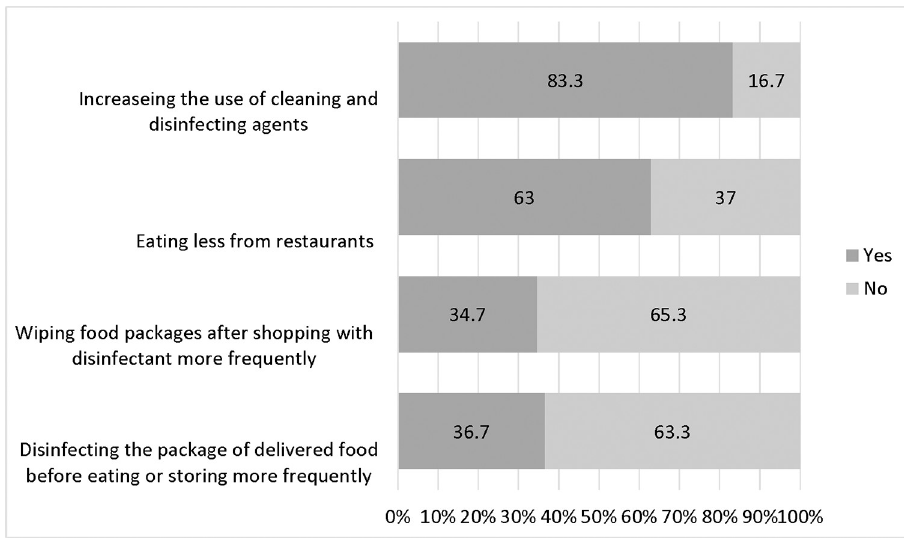
Fig 3. Practices during the COVID-19 (n =